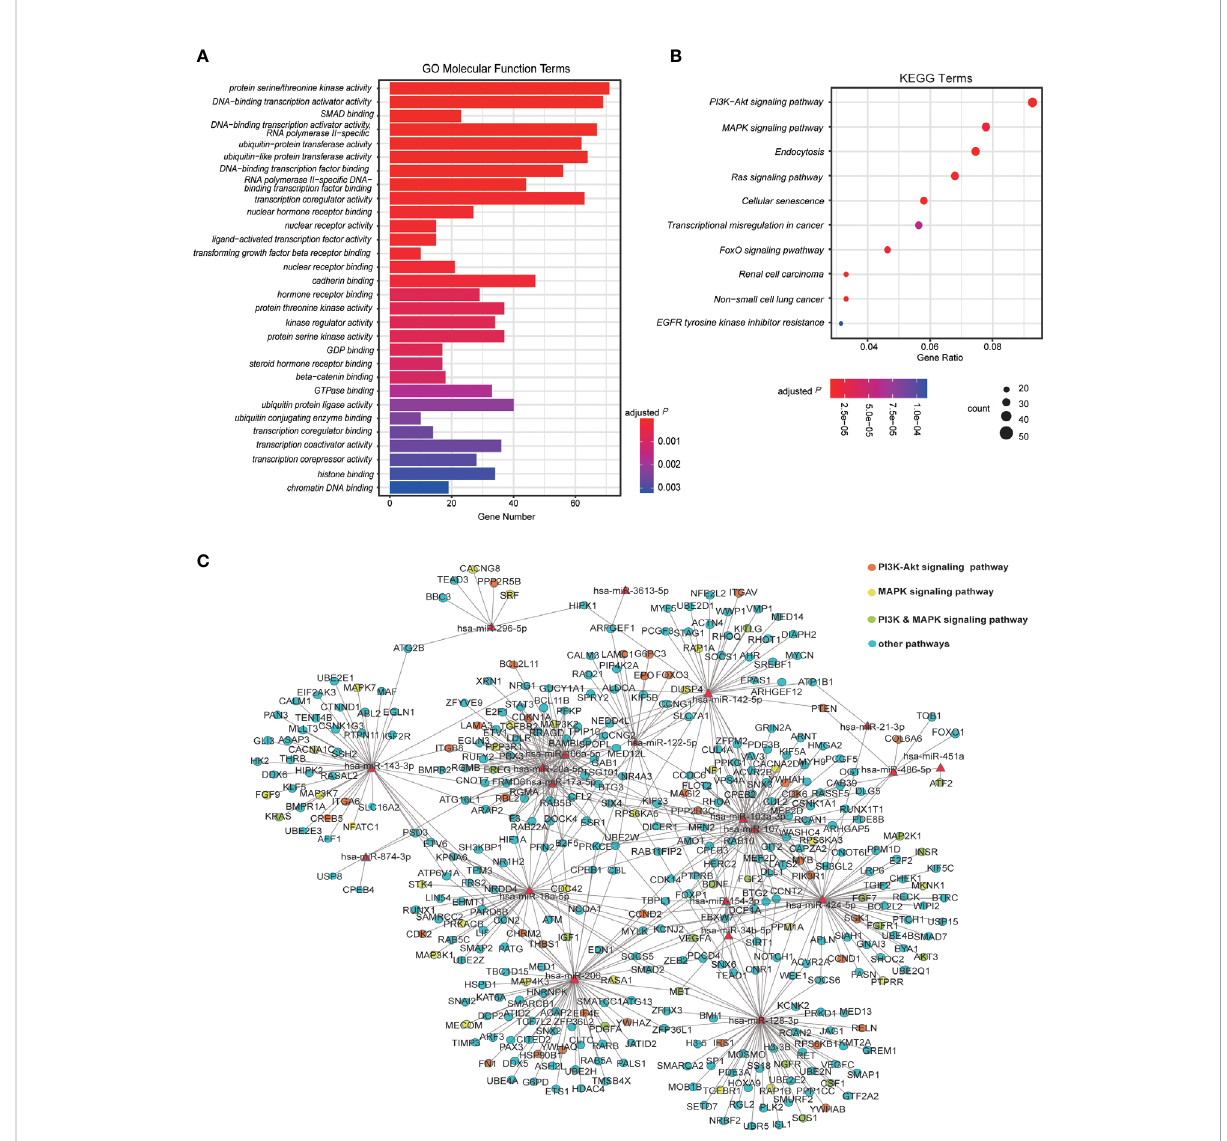
FIGURE 3 Analysis of DE miRNAs and their regulatory pathway. (A) The Gene Ontology (GO) analysis for the enriched functions of genes regulated by the host DE miRNAs induced by viral infection. The top 30 molecular function-related GO enrichment terms of target genes are shown. Terms with adjusted P ≤ 0.05 are recognized as signi fi cantly enriched GO terms. (B) The Kyoto Encyclopedia of Genes and Genomes (KEGG) analysis of target genes signi fi cantly regulated by DE miRNAs in Vero cells infected with SARS-CoV-2 6 hpi/12 hpi vs. controls (n=2). (C) The regulatory network of both up-regulated and down-regulated human miRNA and their target genes enriched in KEGG pathways. The red triangle nodes represent the miRNAs. The red dots are genes speci fi cally regulating PI3K-Akt signaling pathway, yellows are genes speci fi cally regulating MAPK signaling pathway, greens are genes in both pathways, and genes in other pathways are presented in